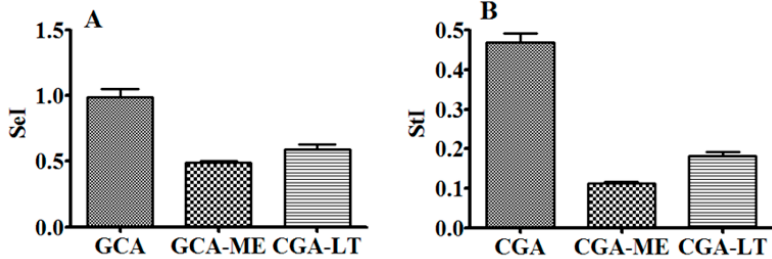
Figure 5. SeI ( A ) and StI ( B ) of CGA, CGA-ME, and CGA-LT ( n = 3).